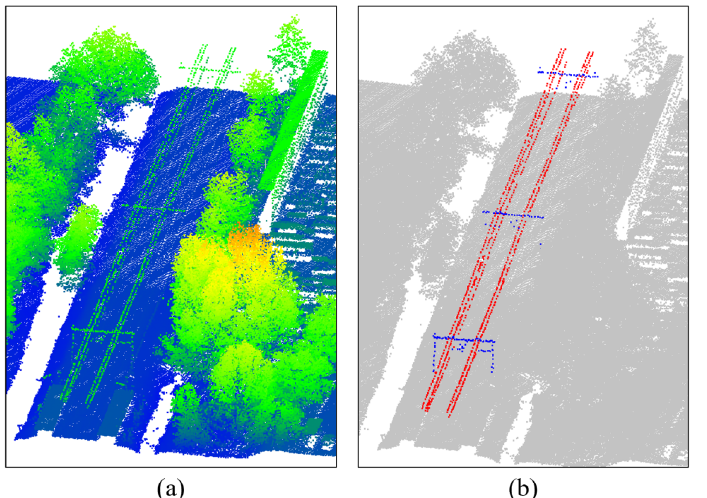
Figure 1. An applicable scenario of the proposed methodology. ( a ) point cloud data of a railway scenario (The points are colorized by height from red to blue); ( b ) overhead wires are automatically segmented and reconstructed by the proposed